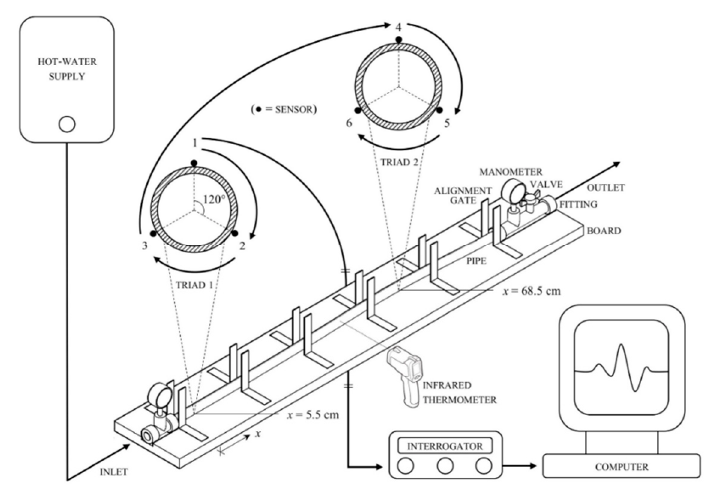
Figure 3. Diagram of the experiment: two threefold arrays of gages were fastened to a polyethylene tube connected to a supply of hot water, the internal pressure was attained by partially opening the outlet valve, temperature was measured with an infrared thermometer, the wavelength shift was acquired by an interrogator, transferred to a computer and converted to the longitudinal strain.